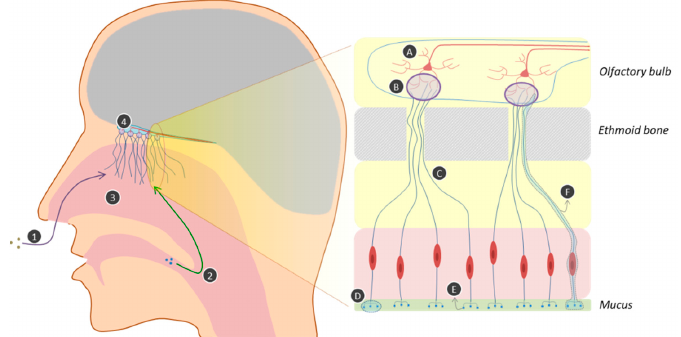
Figure 6. Mechanisms of human olfaction. 1. Orthonasal olfaction; 2. retronasal olfaction; 3. nasal cavity; 4. olfactory bulb; A. mitral cell; B. glomerulus; C. axon; D. cilia; E. olfactory receptor; F. olfactory receptor neuron.